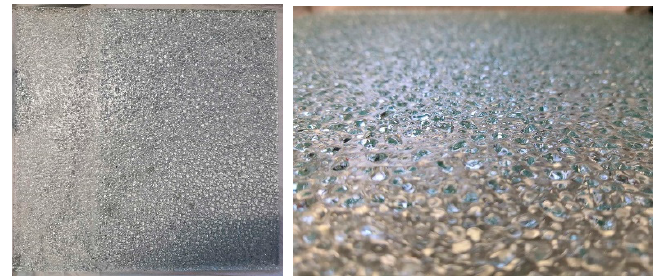
Figure 2. Images of frosted glass.